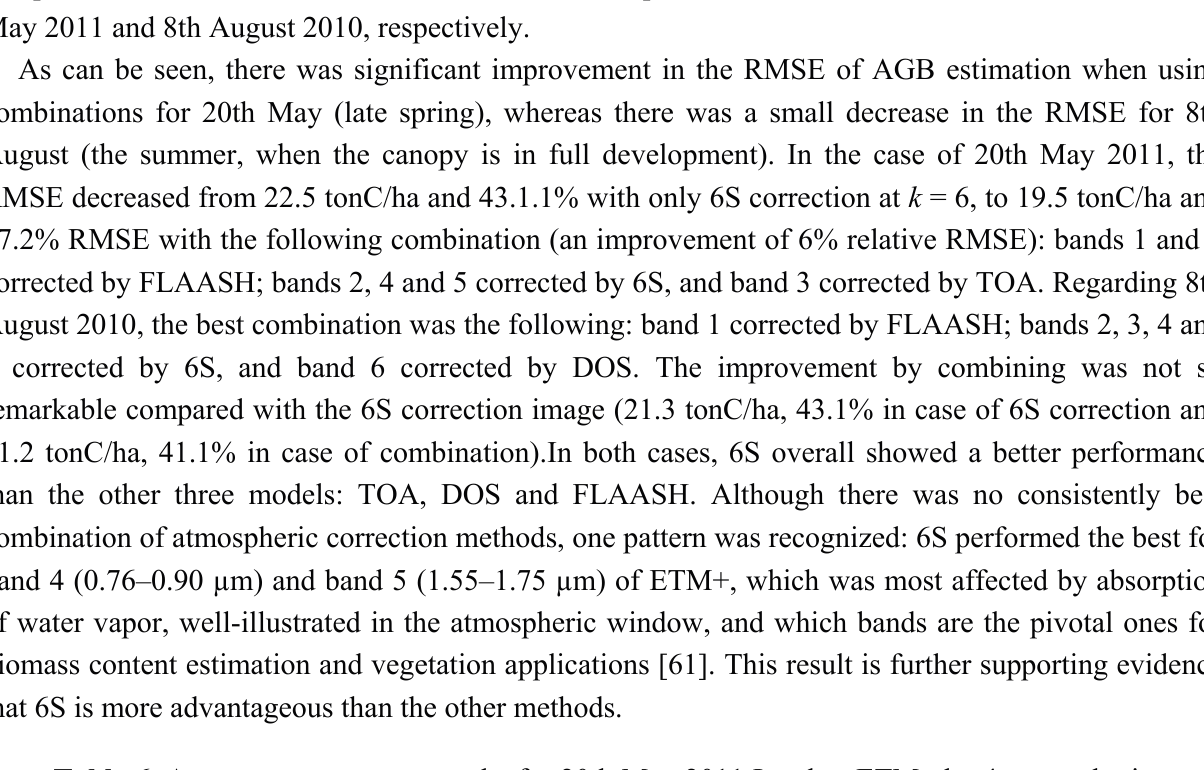
Table 6. Accuracy assessment results for 20th May 2011 Landsat ETM+ by 4 atmospheric cases: RMSE (unit: tonC/ha) and %RMSE (unit: %); for band area: 4 atmospheric correction options, TOA, DOS, FLAASH and 6S are named 1, 2, 3 and 4,